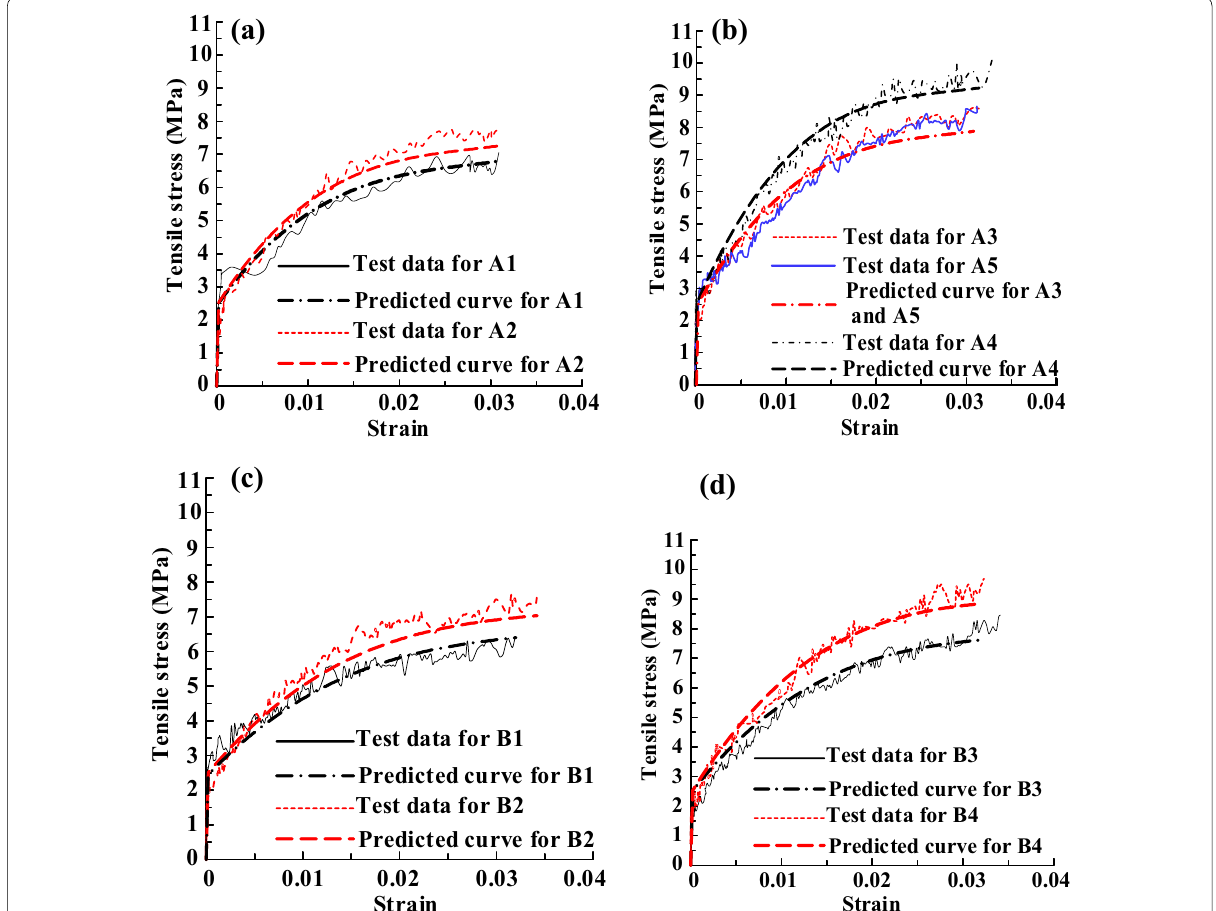
Fig. 11 Test stress–strain curves versus predicted curves using proposed model for a A1 and A2, b A3, A4 and A5, c B1 and B2 and d B2 and B3.